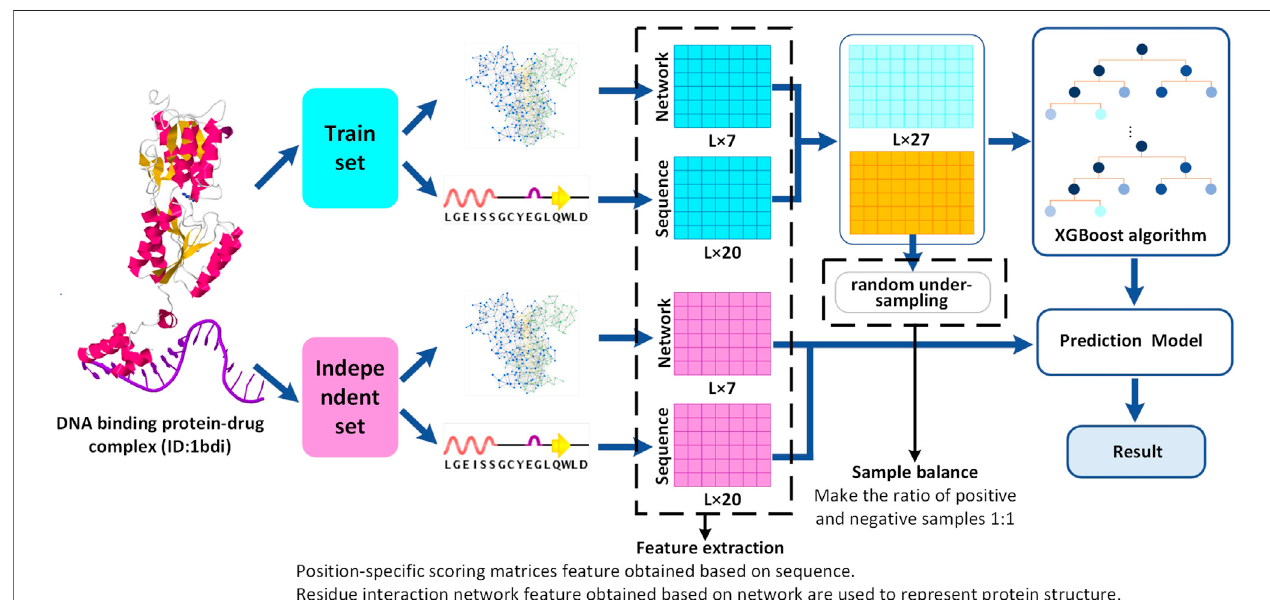
FIGURE 1 | Flowchart of DNA-binding protein – drug-binding sites prediction. Red represents the independent set data, blue represents the training set, light blue, and yellow represent the positive and negative sample data of the training set, respectively. A reference data set of 120 DNA-binding protein – drug complexes is generated from sc-PDB. The characteristic set is composed of network and sequence feature, and a prediction model is constructed by XGBoost. Finally, the performance of the training data set and the independent data set is evaluated.